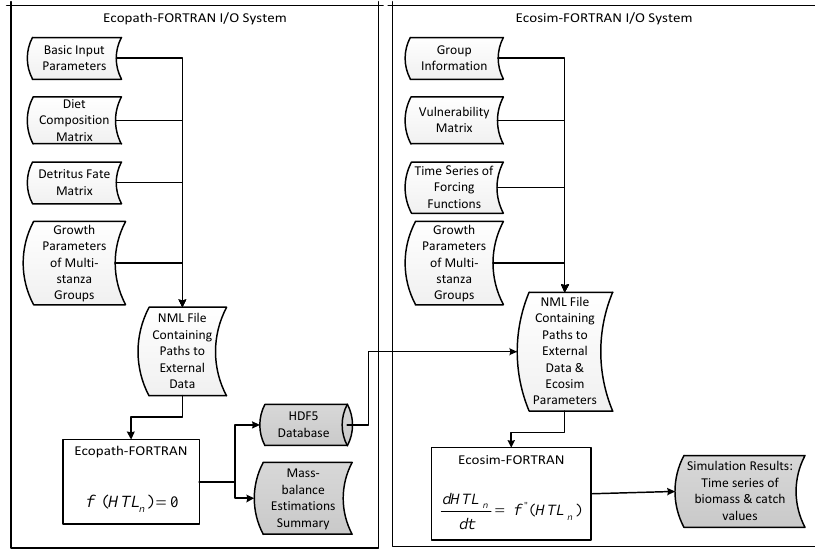
Figure 1. The EwE-F data input/output scheme. Curved white rectangular boxes denote tab-delimited ASCII files providing external data input to the EwE-F models (rectangles). Curved grey-shaded rectangles and the cylindrical box denote the model output via tab-delimited ASCII and HDF5 files respectively. For details see Sect. 3.1 and